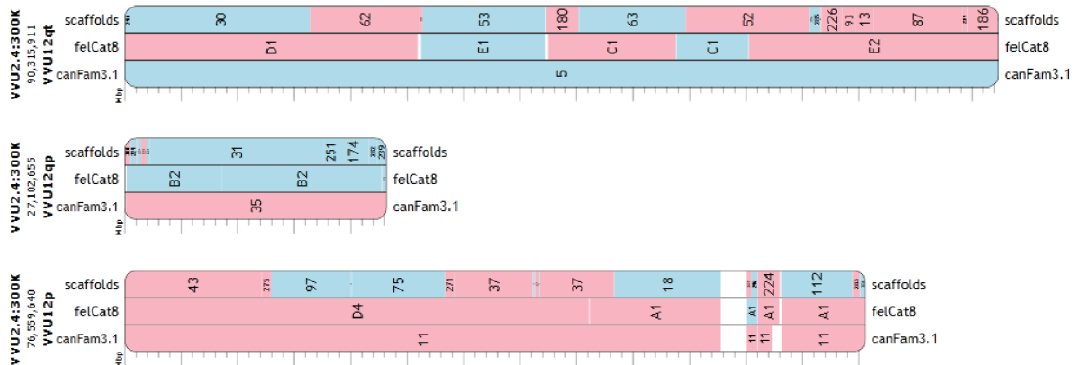
Figure 4. View of fox, dog, and cat synteny along fox chromosome 12. Interspecies chromosome-scale synteny has been visualized in Evolution Highway [61]. The fox scaffolds comprising vv2.2 and the final 40 fragments comprising vv2.4 are included in the visualization. Red represents fragments that run negative relative to the fox chromosome fragments (i.e., opposite strand), whereas blue fragments run in the same direction. Table 2. Conserved synteny between cat and fox relative to dog. Alignment of the dog genome assembly (CanFam3.1) and cat genome assembly (FelCat5). Top: against VVU4; bottom: against VVU13. In these three cases, fox and cat map in a single syntenic block whereas fox and dog map in two blocks, as indicated by bold text. The cat syntenic blocks spanning two dog syntenic blocks are shaded. Genomic positions in CanFam3.1 and FelCat5 are indicated. * Indicates chromosome comprised by two dog-fox syntenic blocks.